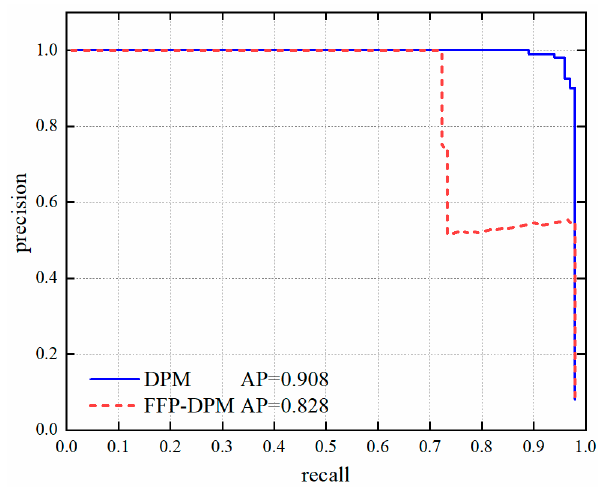
Figure 9. Precision and recall curve of DPM algorithm and FFP-DPM algorithm.